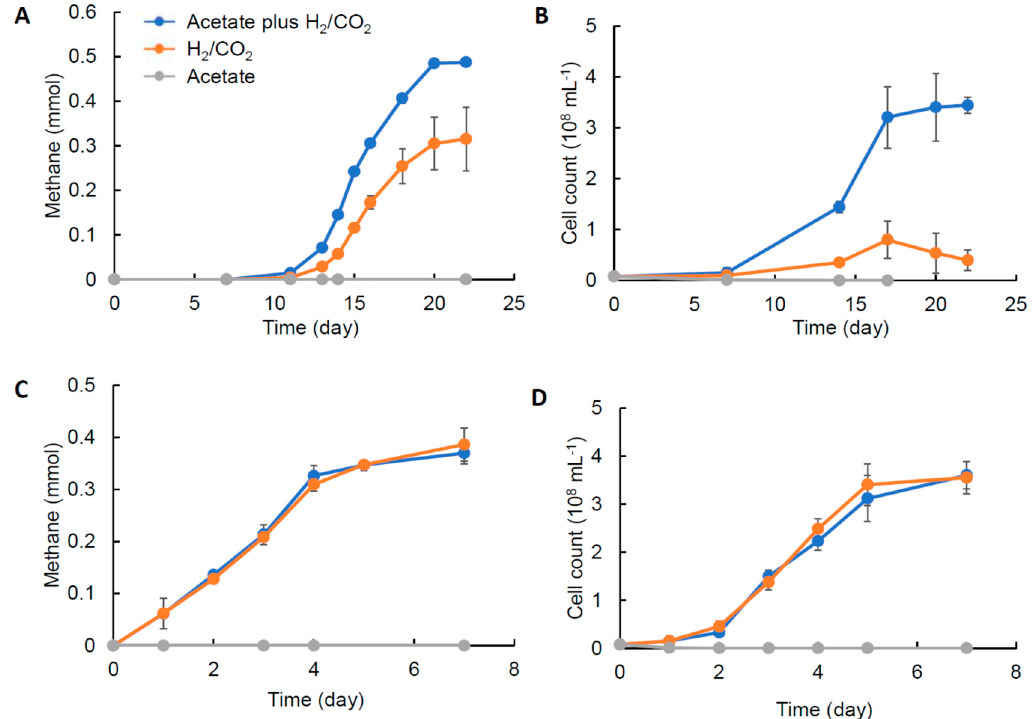
Figure 3. Methanogenesis ( A , C ) and growth ( B , D ) of Methanothermobacter sp. Met2-1 ( A , B ) and M. thermautrotrophicus Δ H ( C , D ) on three different substrates.